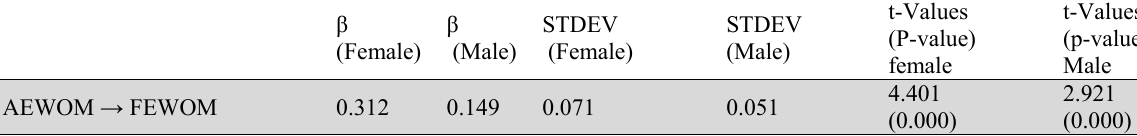
Moderating effect of Gender between AEWOM and